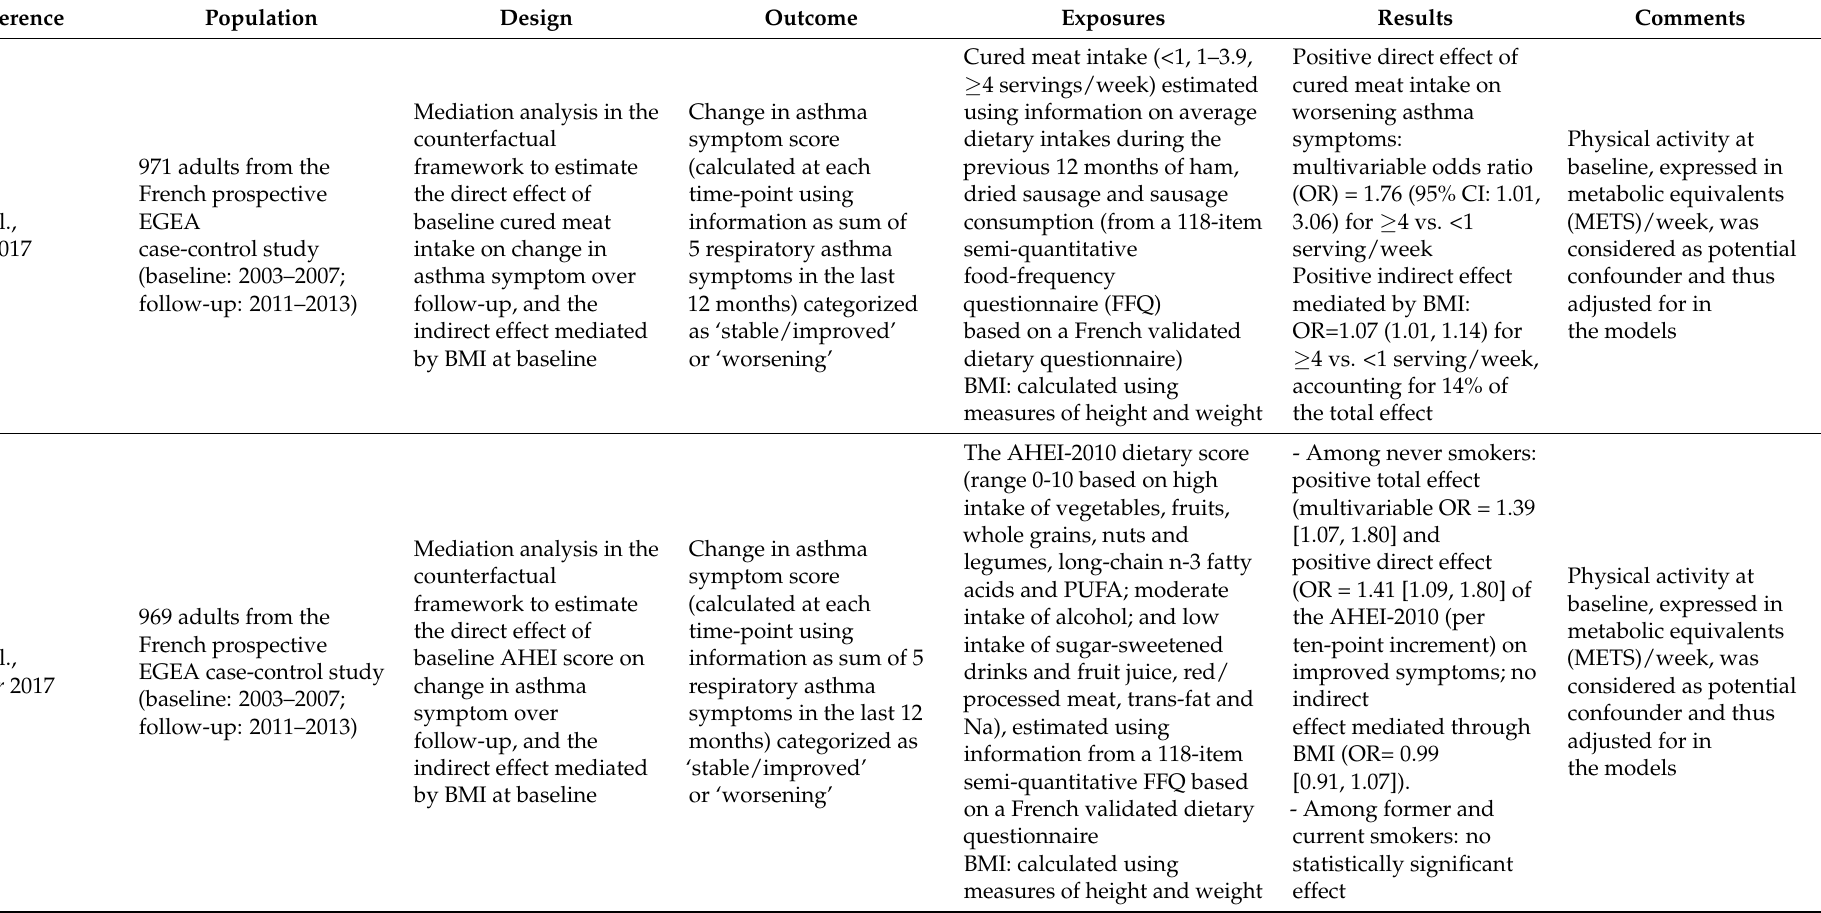
Table 1. Studies that used methods from the causal inference framework to investigate associations between nutritional factors and